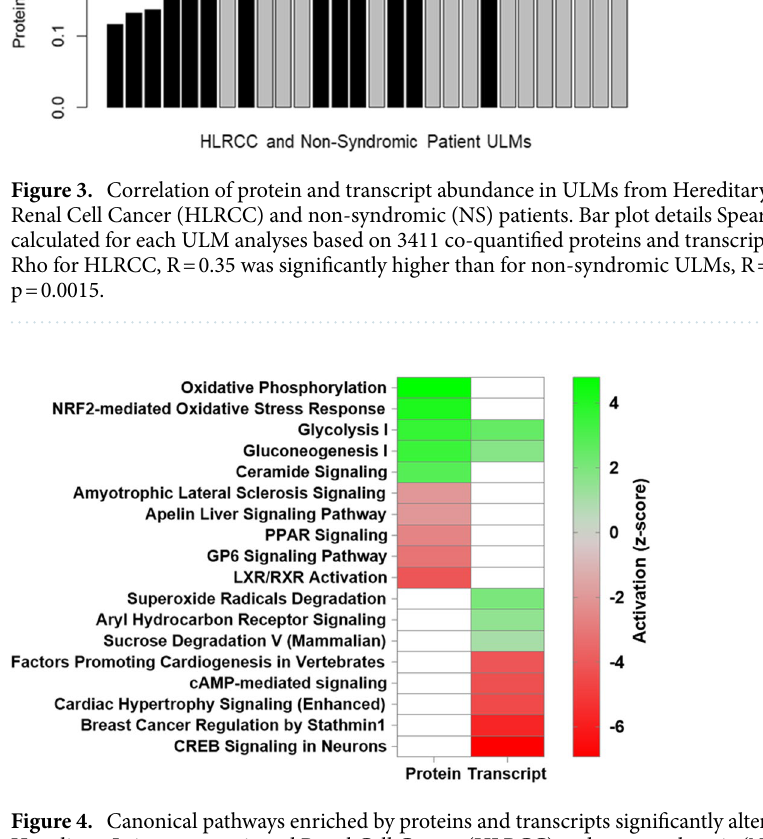
Figure 4. Canonical pathways enriched by proteins and transcripts significantly altered in ULMs from Hereditary Leiomyomatosis and Renal Cell Cancer (HLRCC) and non-syndromic (NS) patients. Heatmap reflects the top 10 canonical pathways predicted as activated (positive z-score) or inhibited (negative z-score) based on proteins and transcripts significantly altered between HLRCC and non-syndromic ULMs (LIMMA adjusted p < 0.01). Pathways colored white not among top pathways predicted to be activated or inhibited in protein or transcript level data. Functional enrichment and causal analyses performed using Ingenuity Pathway Analysis 15